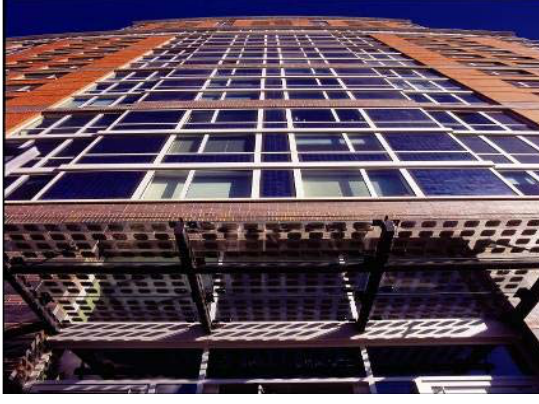
Figure 2. The Solaire’s West façade, seen from the pathway [19].